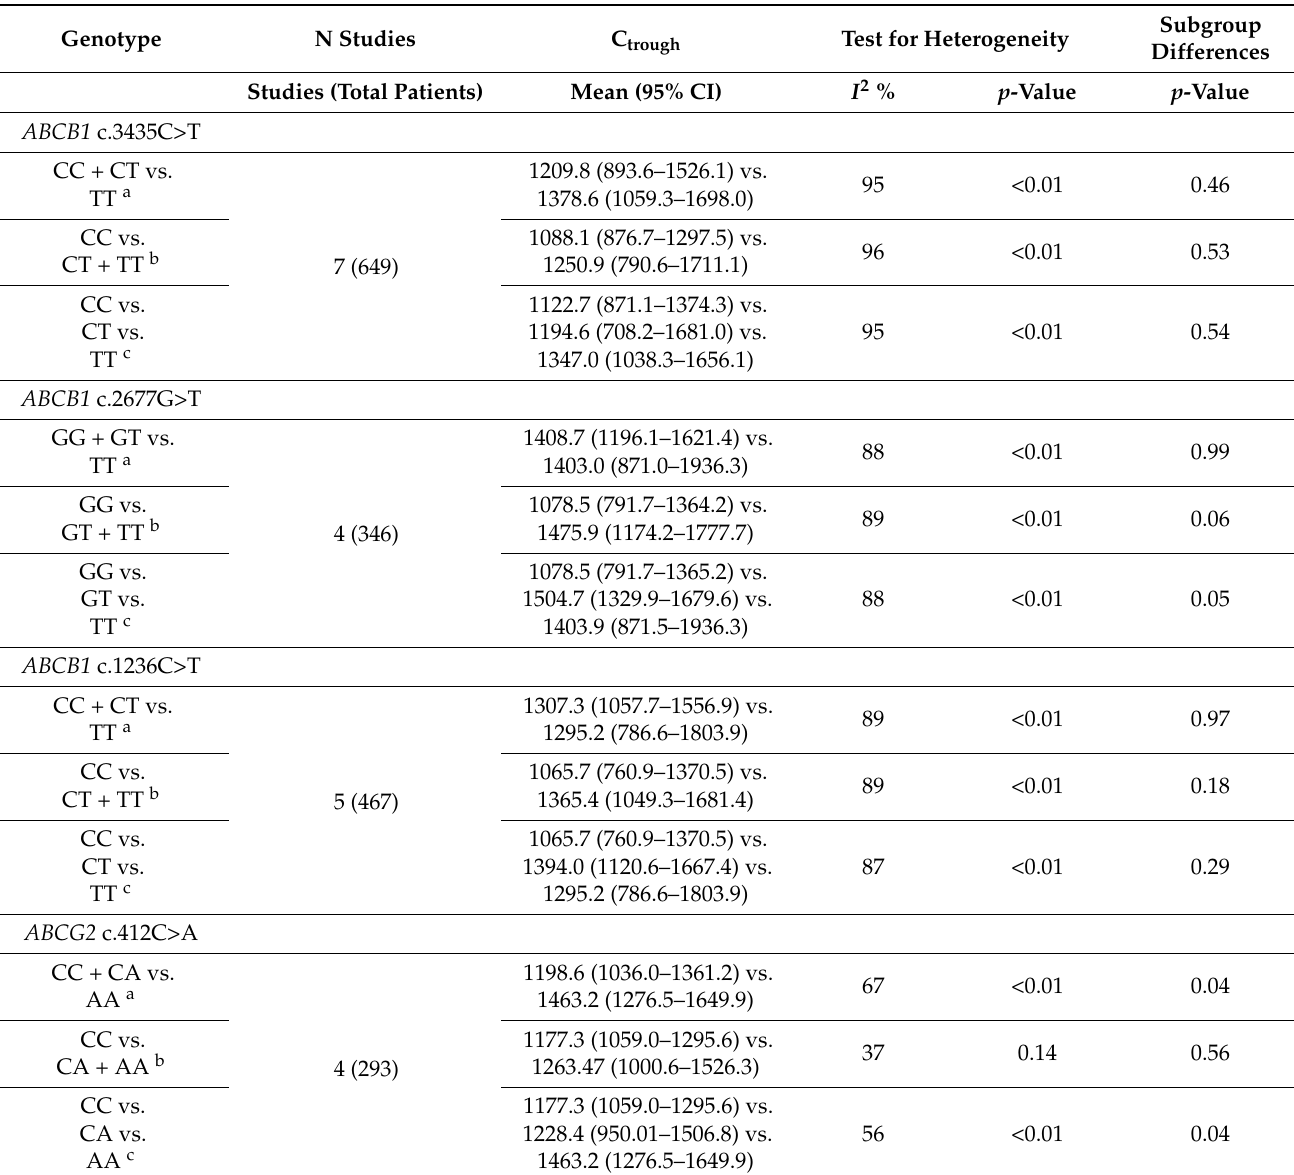
Table 5. Summary of random effect meta-analyses for ABCB1 c.3435C>T, c.2677G>T/A,